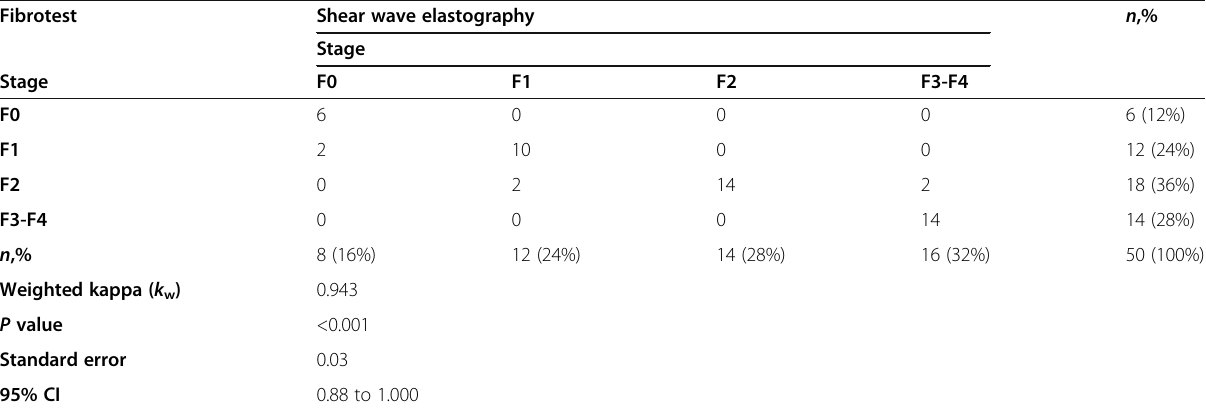
Table 3 Degree of agreement between results of elastography and Fibrotest Fibrotest Shear wave elastography